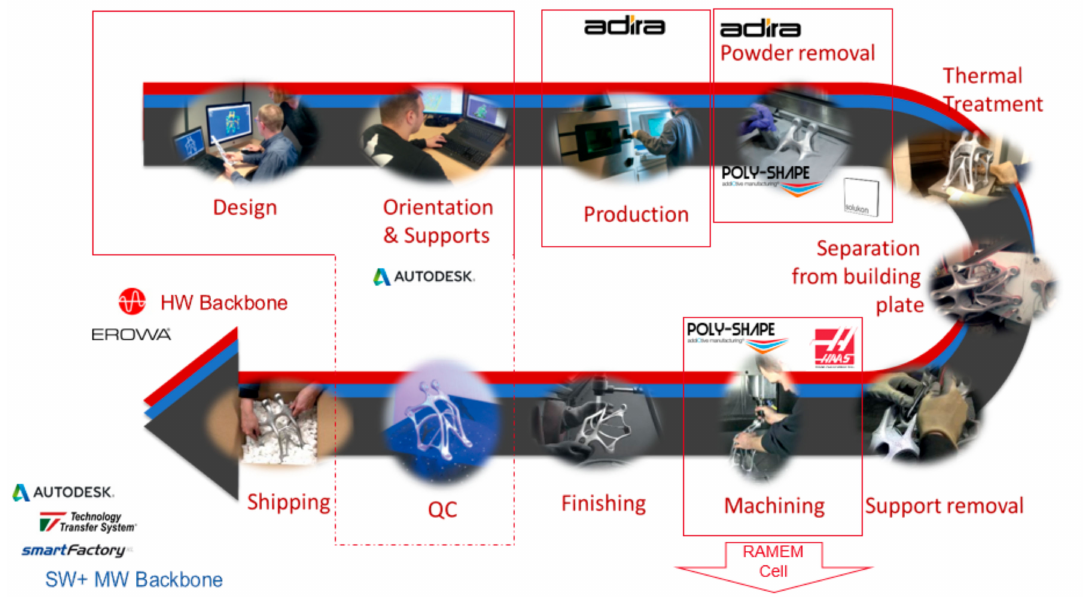
Figure 12. AM value chain and stages involved. Identification of stages and processes addressed (red Boxes) in the SLM pilot cell at POLY-SHAPE.